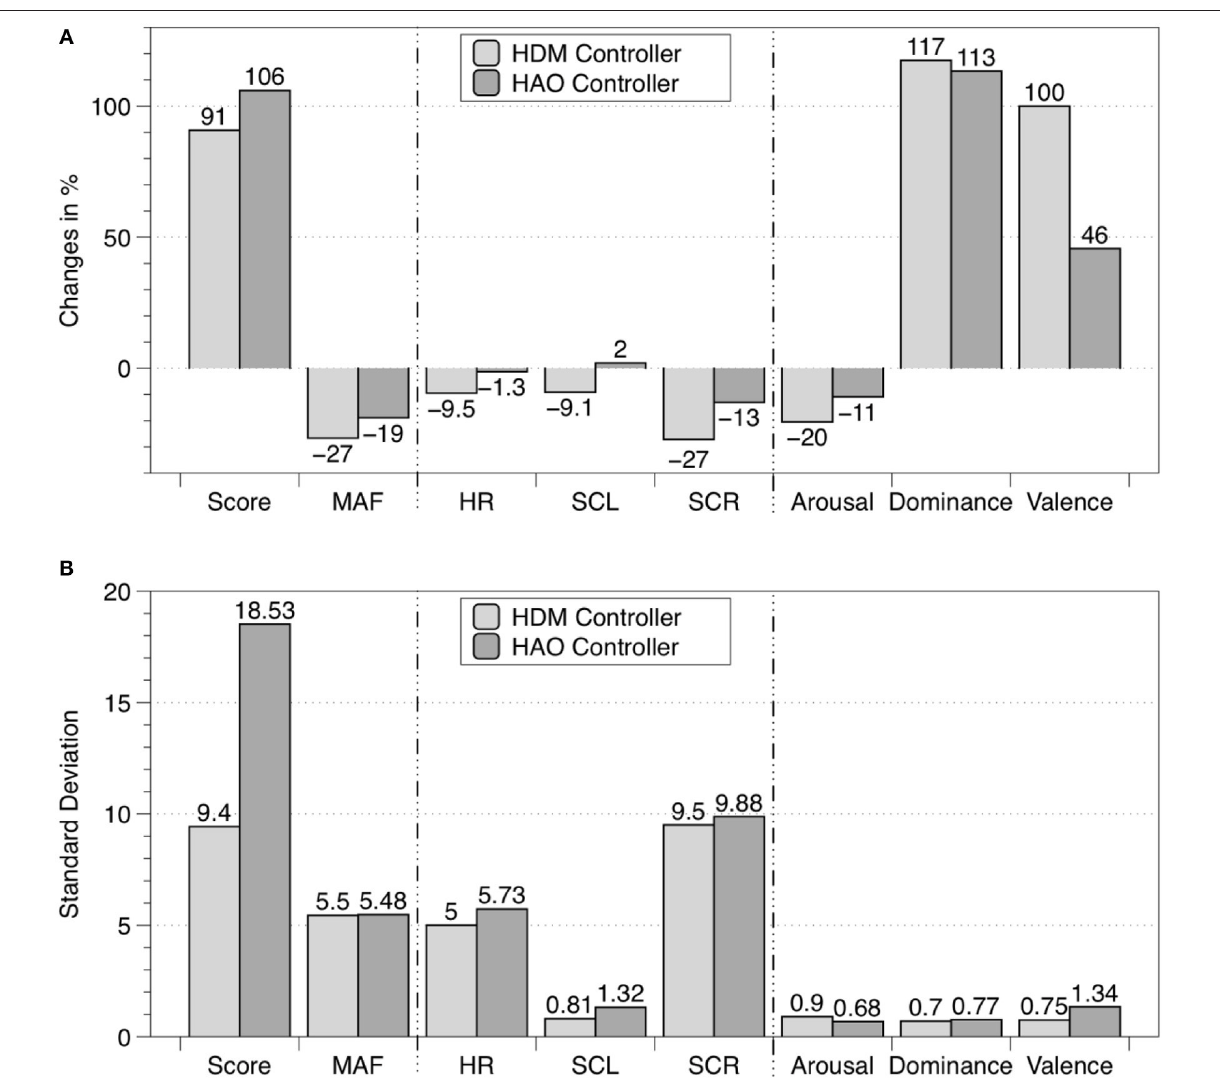
FIGURE 6 | (A) Percentage change between baseline (i.e., calibration task) and the closed-loop experiments for the eight measured variables. (B) The corresponding standard deviations. Light gray bars represent the data obtained for the HDM controller described in this article, and dark gray bars represent data from the HAO controller published in Rodriguez Guerrero et al. (2013). In both cases the sample sizes were n =